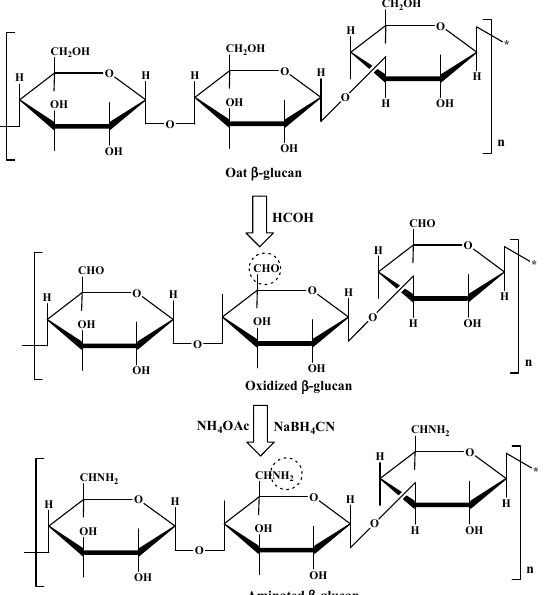
Figure 11. Schematic representation of reductive amination of b-glucans. Taken from reference [74] with permission of the American Chemical Society.